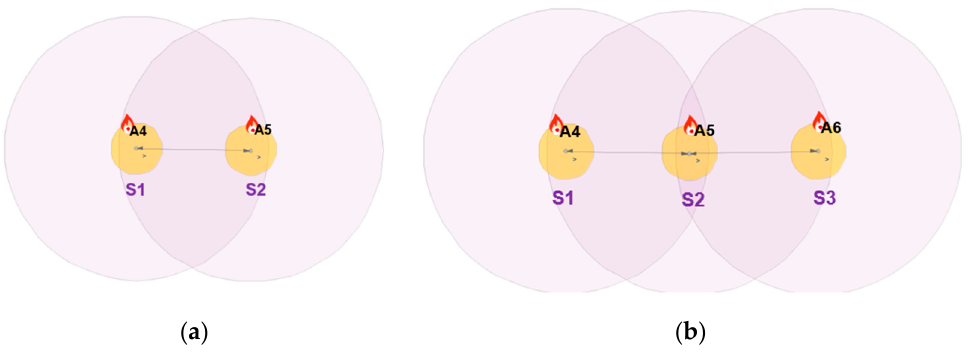
Figure 4. Simulation setup in CupCarbon: ( a ) with two nodes; ( b ) with three nodes.